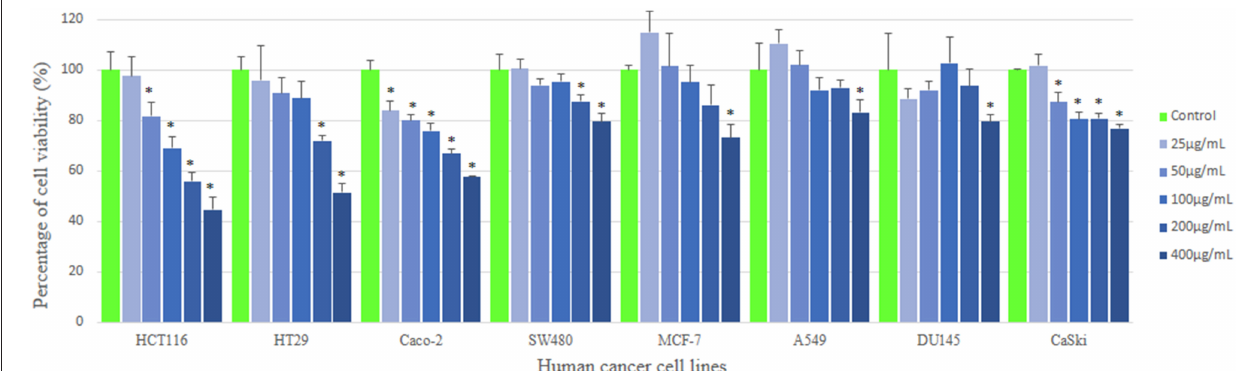
FIGURE 2 | Anticancer activity of MUM256 extract against human cancer cell lines. The anticancer activity of streptomyces sp. Mum256 extract against all the cancer cell lines measured using mtt assay. Each bar represents the mean of the cell viability of the cell lines after treatment with extract at respective concentrations tested ( n = 5 ). The vertical lines associated with the bars represent the standard deviation of the mean. Symbol (*) indicates p < 0.05 significant difference compared to control.